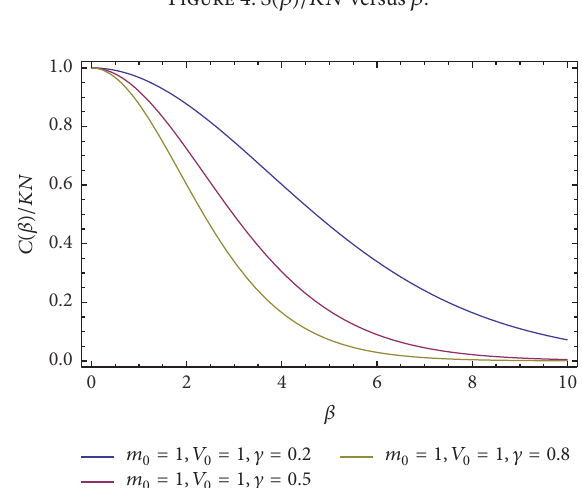
Figure 2: 𝑄 1 (𝛽) versus 𝛽 .